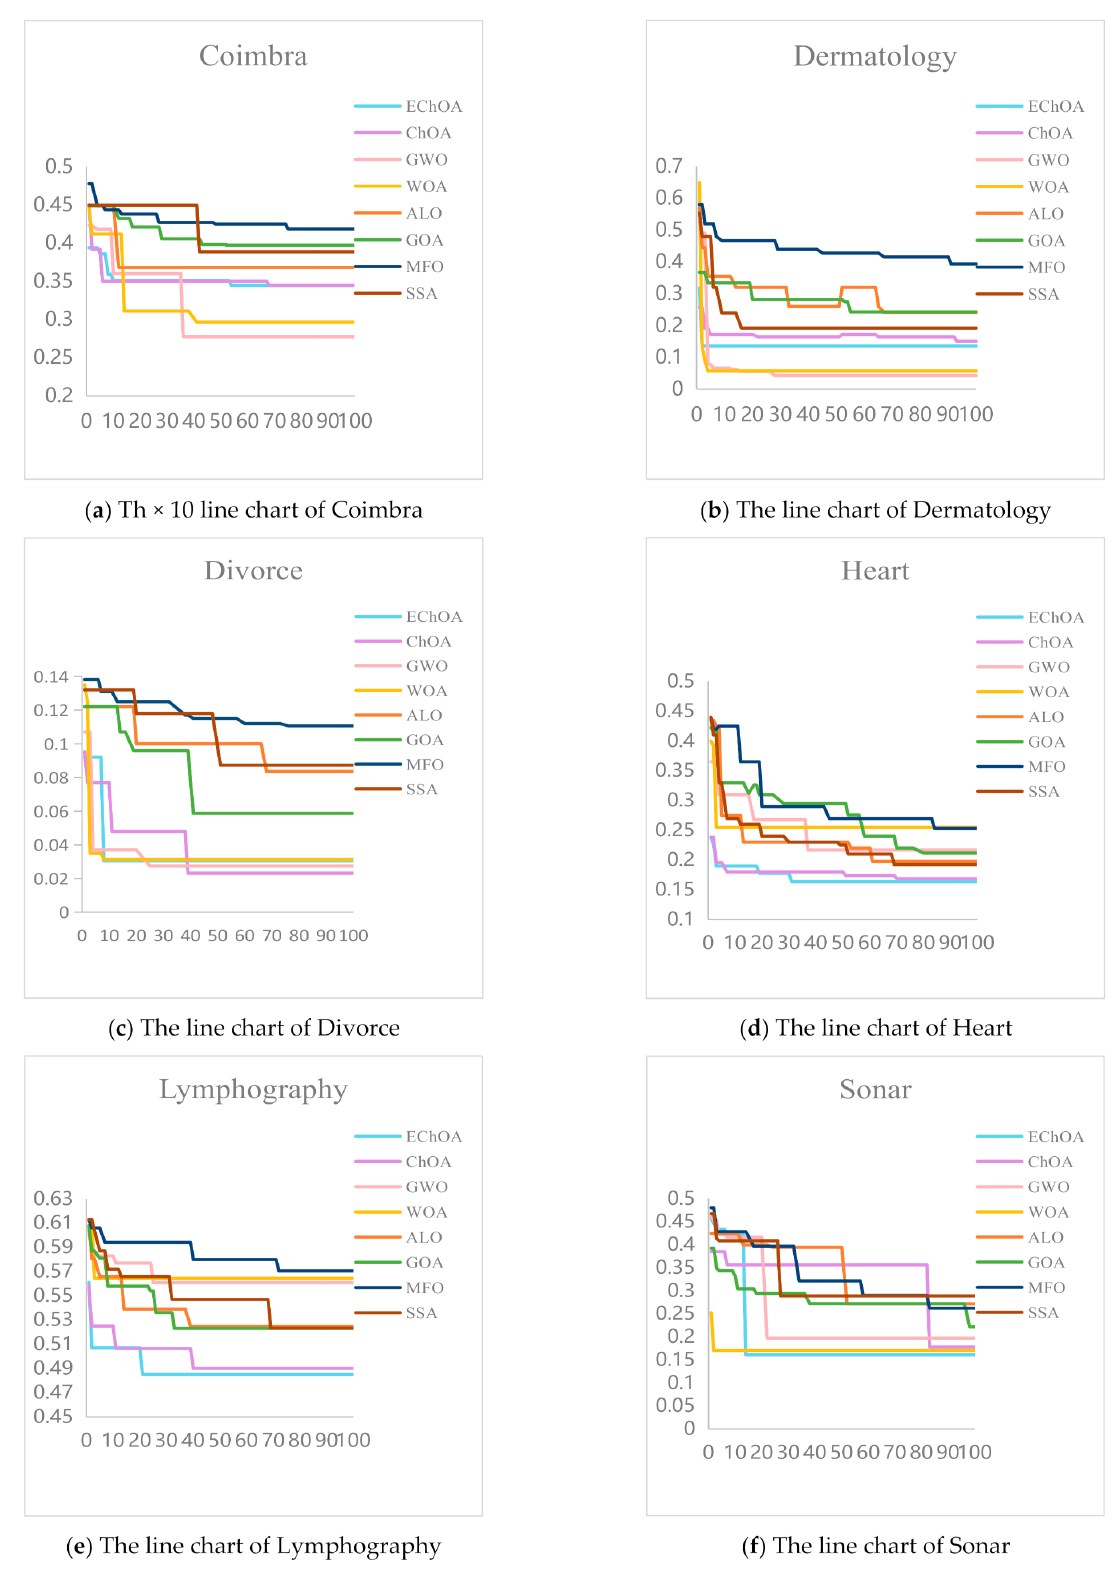
Figure 5. The line chart for the fitness of EChOA and other algorithms based on 17 data